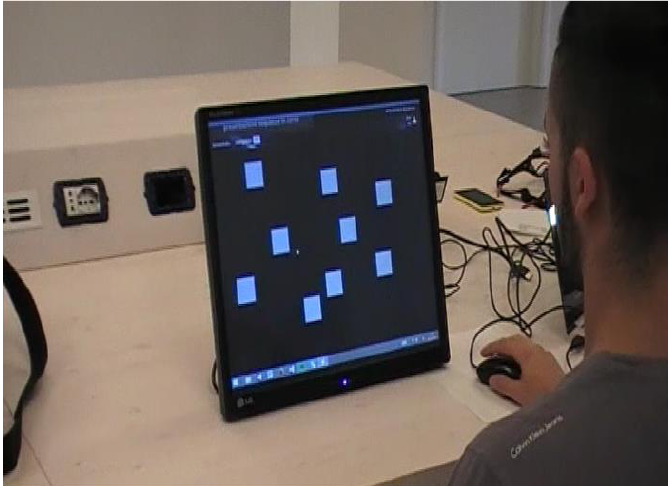
Figure 1. The digital version of Corsi’s test (eCorsi test).